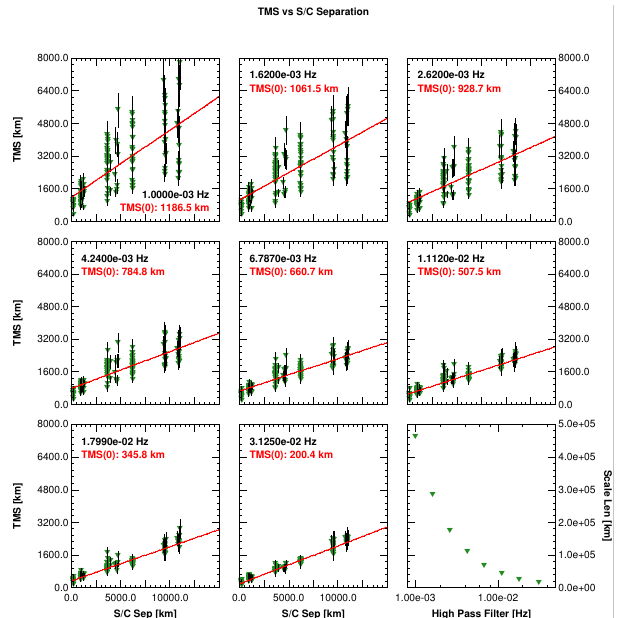
Fig. 5. Functional dependence of the estimated λ T values from mag- netic field data on the spacecraft separation for all eight cutoff fil- ter frequencies. The cutoff filter frequency as well as λ T at zero spacecraft separation are given in each plot. The latter was com- puted directly from the fits. The bottom right-hand plot shows the relationship between λ T (0) and the cutoff filter frequencies.